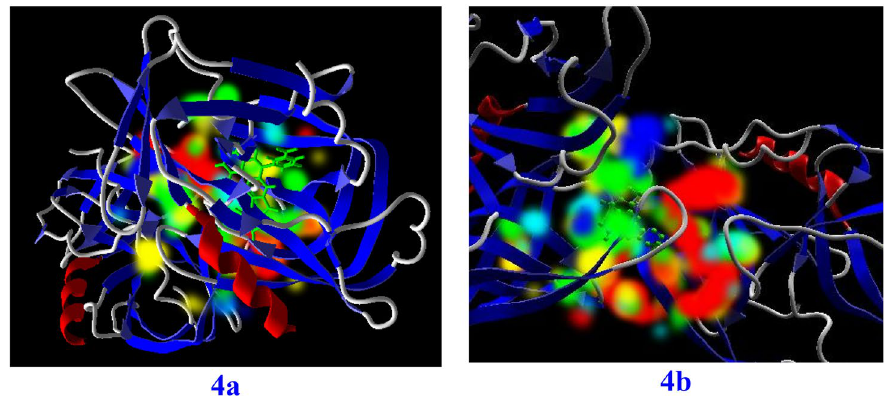
Figure 6. Energy map of fused quinoline (4a, 4b) at the binding cavity of Hepatitis